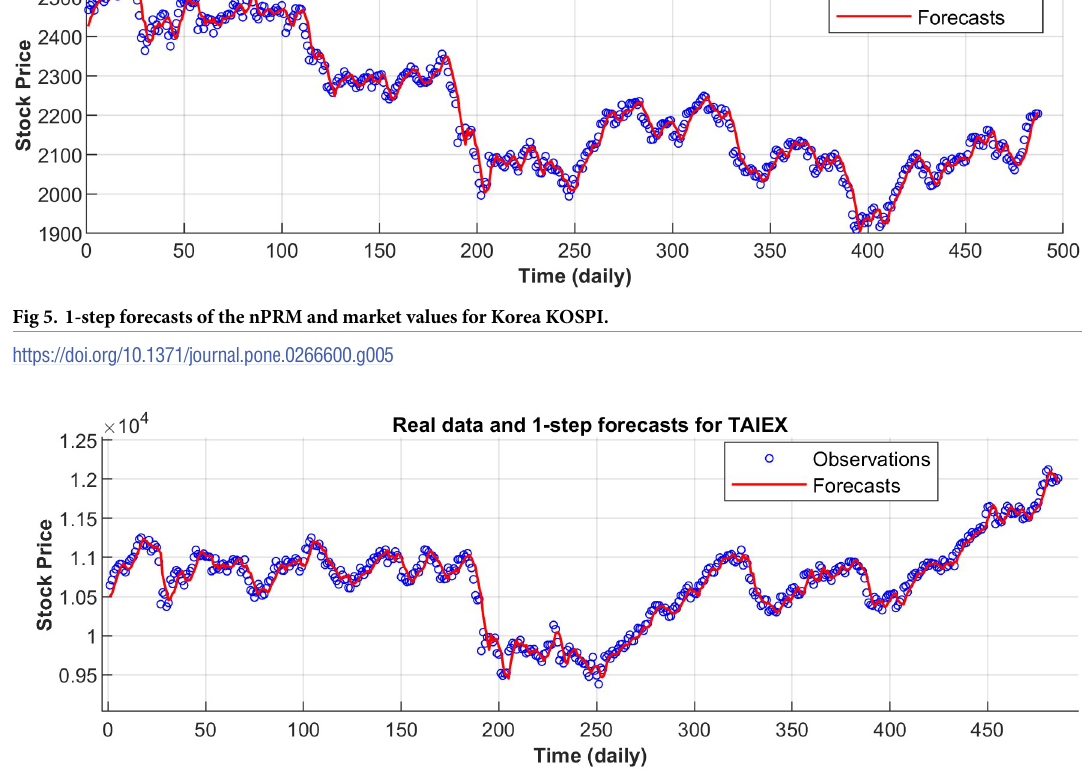
Fig 6. 1-step forecasts of the nPRM and market values for Taiwan TAIEX.